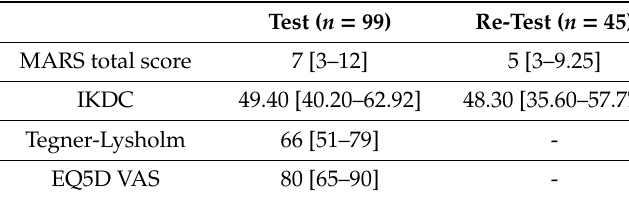
Table 2. Questionnaire results presented as median and interquartile range; Marxactivityratingscale(MARS),InternationalKneeDocumentationCommittee (IKDC) and EuroQol visual analogue scale (EQ5D